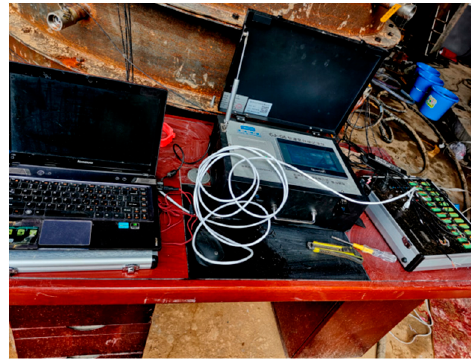
Figure 5. Grouting recorder.